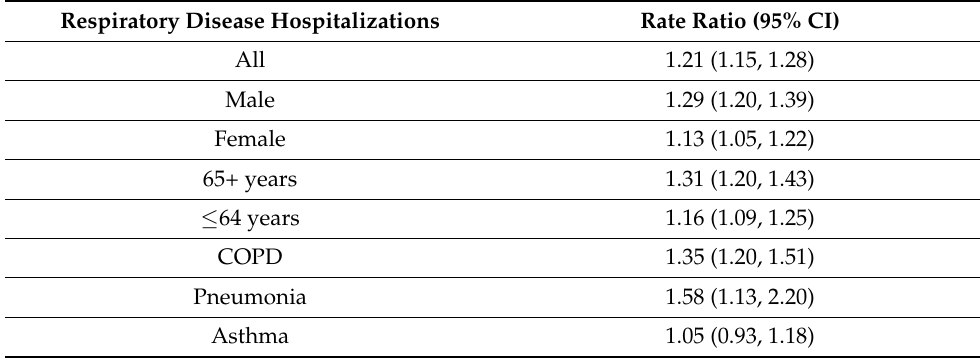
Table 4. Associations of respiratory disease hospital admissions during the high air pollution period compared to the low air pollution